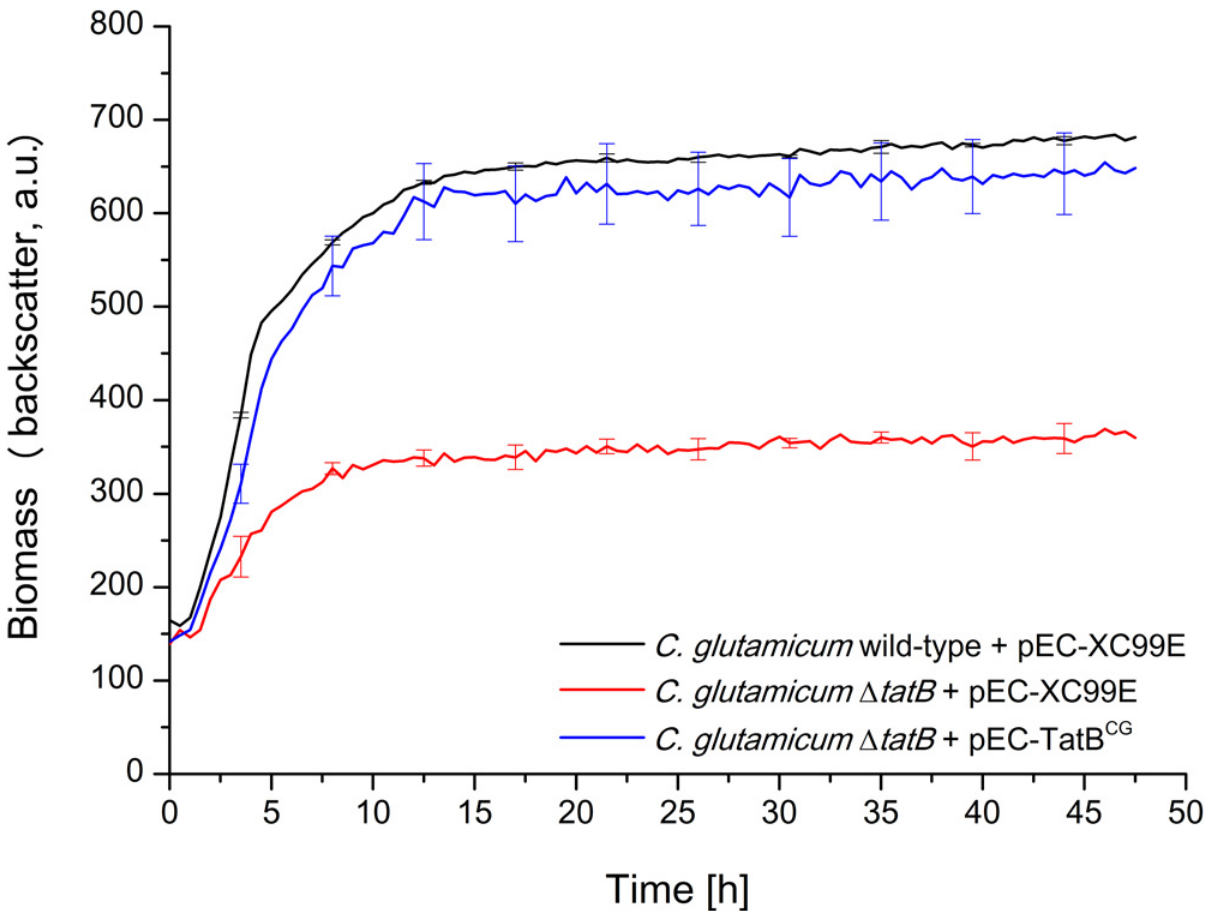
Fig 2. The growth defect of the C . glutamicum Δ tatB mutant is reversed by expressing the C . glutamicum TatB in trans from plasmid pEC-TatB CG . Cells were inoculated to an OD 600 of 0.5 in 750 μ l BHIS medium containing 10 μ M IPTG and cultivated in 48-well FlowerPlates in a BioLector system for 48 h at 30°C, 1100 rpm under constant 85% relative humidity. Growth of the respective C . glutamicum strains, as indicated in the figure, was monitored as backscattered light (620 nm; signal gain factor 20) in 15 min intervals. The growth curves show one representative experiment of three independent biological replicates. Standard deviations are given for 10 selected time points. a.u.: arbitrary units.